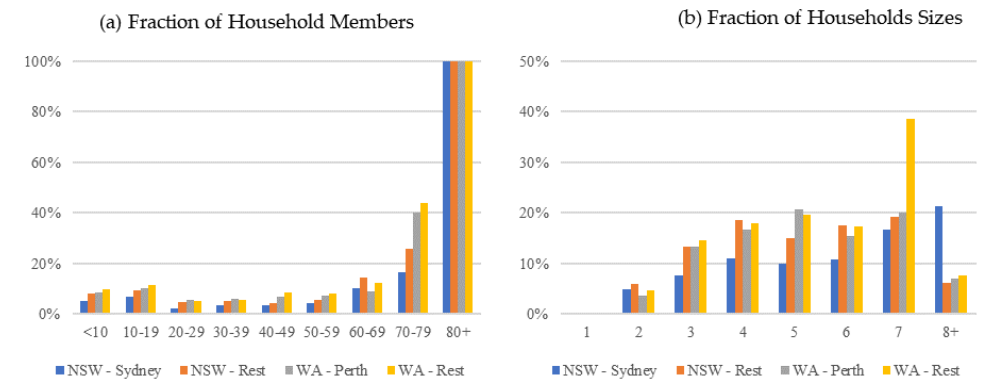
Figure 7. Distributions of ages and household sizes: ( a ) ages of household members; and ( b ) distribution of the patient zero when the total cost of home isolation is above the state hotel quarantine costs. Fractions are calculated by dividing the number of individuals in different age groups and household sizes, when the total cost of home isolation exceeds the state hotel quarantine costs, by the total number of individuals in different age groups and household sizes in the sample.